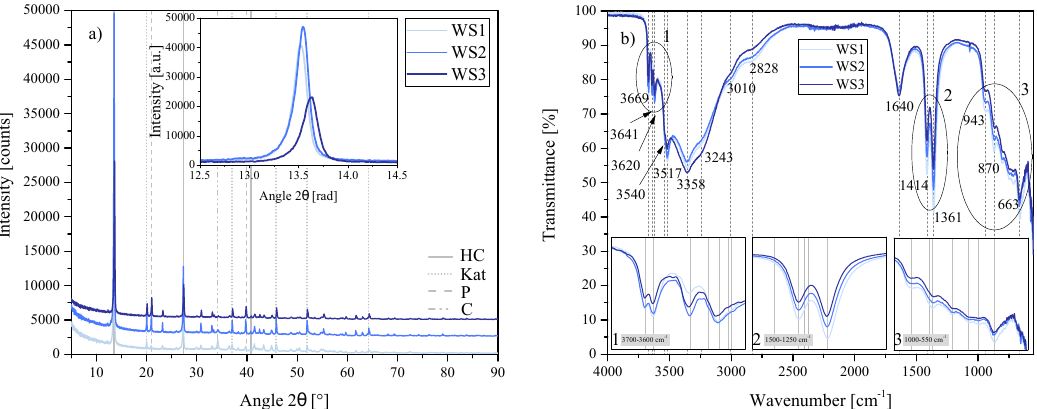
Figure 22. ( a ) XRD results of the water-to-solids ratio series WS1, WS2 and WS3 between 5 ◦ 2 θ and 90 ◦ 2 θ . Each scan is y-shifted by 2500 counts. The inset depicts the primary LDH peaks and change in position. HC = hydrocalumite, Kat = katoite, P = portlandite and C = calcite. ( b ) FTIR-ATR scans of the water-to-solids ratio series WS1, WS2 and WS3 between 4000cm − 1 and 550cm − 1 . The three insets show the regions: ( 1 ) 3700cm − 1 – 3600cm − 1 , ( 2 ) 1500cm − 1 – 1250cm − 1 , ( 3 ) 1000cm − 1 – 550cm − 1 in detail. Dashed and solid grey lines indicate the maxima of vibrations. WS1 = 70:30, WS2 = 80:20 and WS3 =